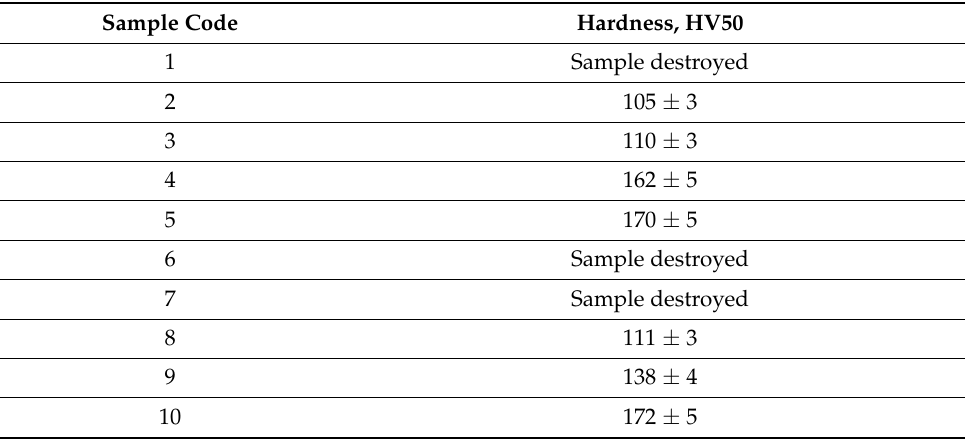
Figure 6. Results of XPS analysis: survey spectrum of the original surface. Table 3. Elemental composition at printed samples surface. Table 2. Microhardness results of the obtained